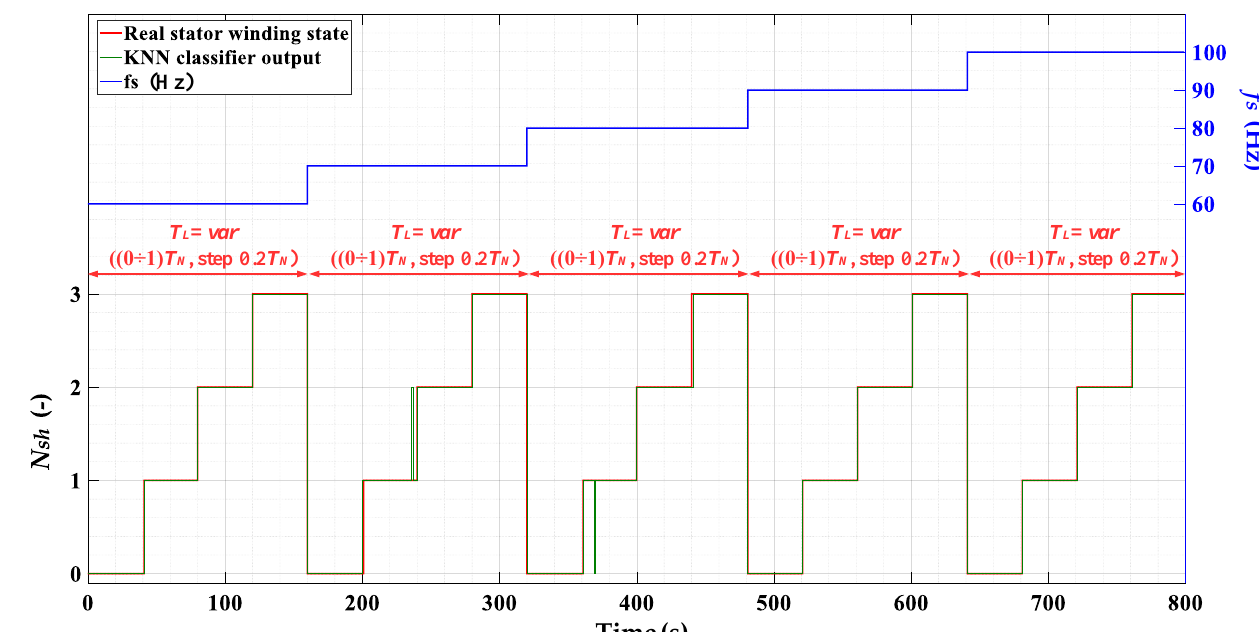
Figure 16. KNN-based stator winding fault classifier responses during the on-line operation—Test 3 ( f s = var, T L = var).